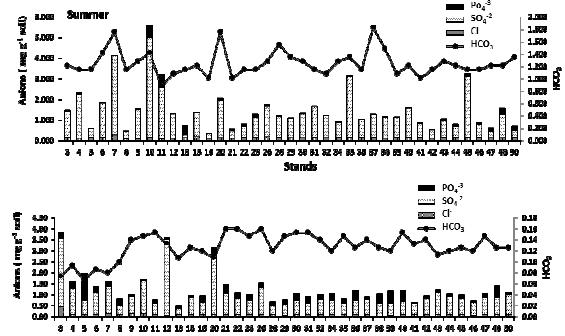
Fig. 3. Concentration of Cl - (expressed in mg g -1 soil), SO 4-2 , PO 4-3 (expressed in µg g -1 soil) and HCO 3 (%) of the different studied stands inhabited by studied plants in Wadi El-Assiuty in winter and summer season